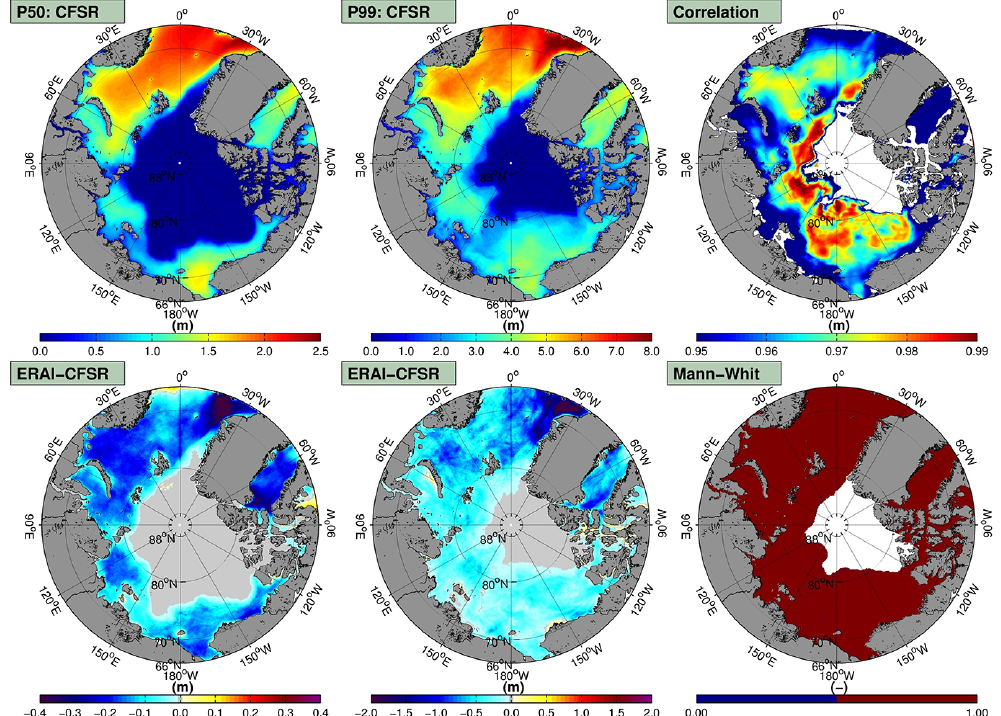
Figure A3. The 50th and 99th H s CFSR percentiles (2010–2014) (top left and middle panels). ERAI–CFSR 50th and 99th percentiles are given in the bottom left and middle panels. The top right panel shows the correlation coefficients between ERAI and CFSR for a monthly averaged time series between CFSR and ERAI. The Mann–Whitney test is presented in the bottom right panel at the 99.9% confidence limit.